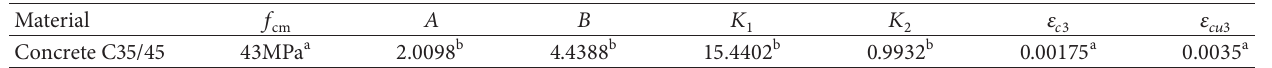
Table 5: Ottosen plasticity criterion parameters for C35/45 concrete.